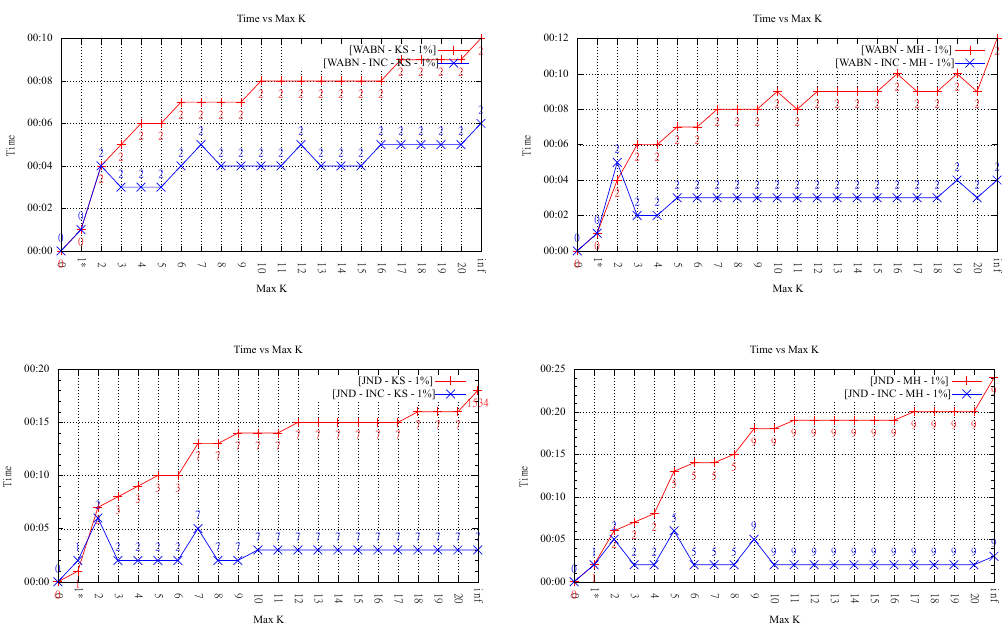
Figure 8. Running times for Kinzel Springs (left) and Moorehead SE (right) for 1% sample set size as the maximum order k increases, for ABN, WABN and JND. * Analysis for the exact algorithms is presented in Section 4.4; thus, results for those algorithms are not exhibited